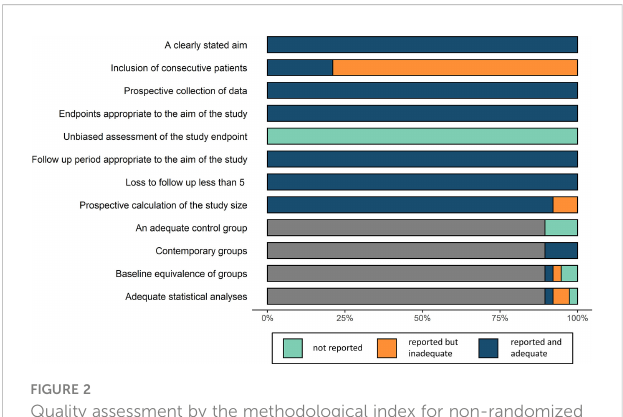
FIGURE 2 Quality assessment by the methodological index for non-randomized studies (MINORS) index.